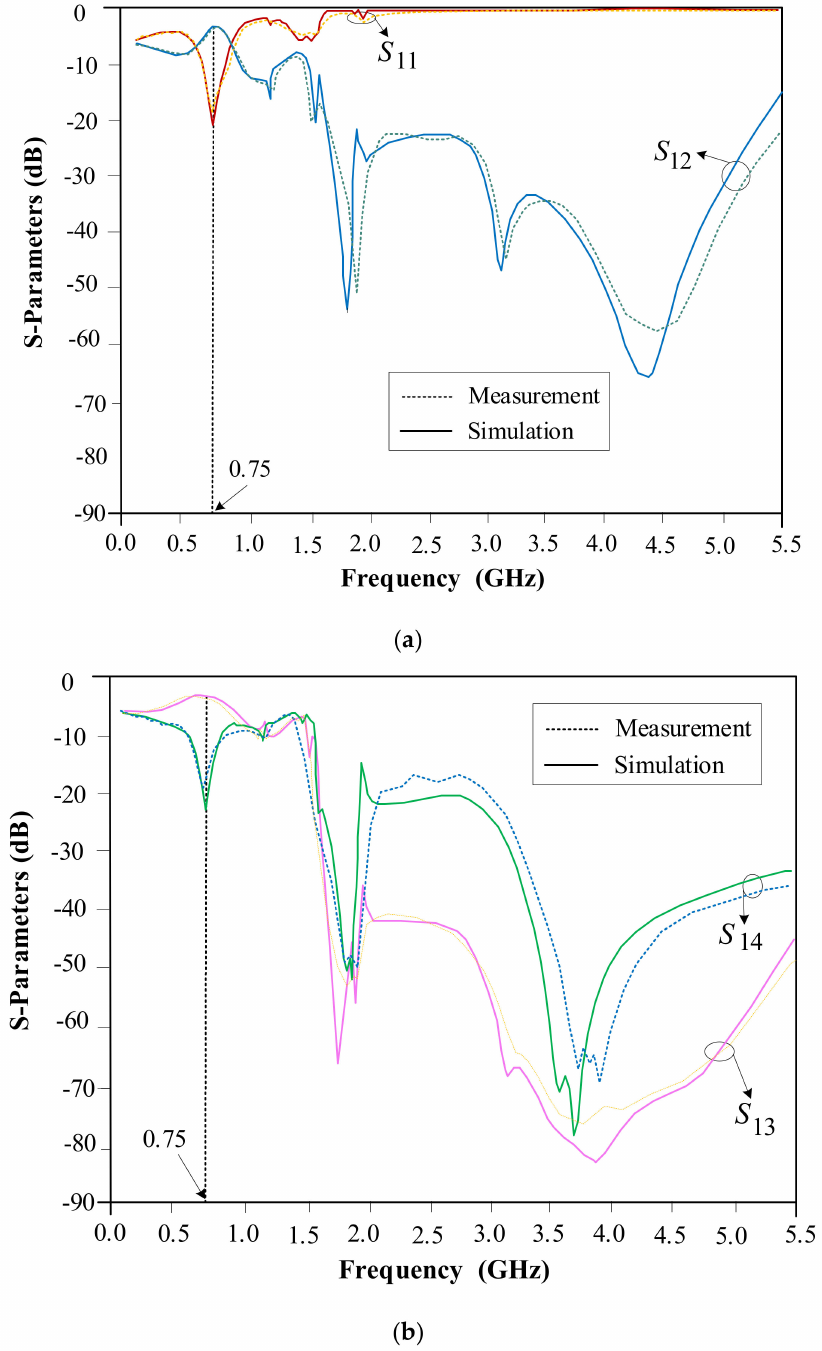
Figure 17. Measurement and EM simulation of the S-parameters with respect to frequency for the final prototype of the designed BLC. ( a ) The values of | S 11 |, and | S 12 | parameters. ( b ) The values of | S 13 |, and | S 14 |